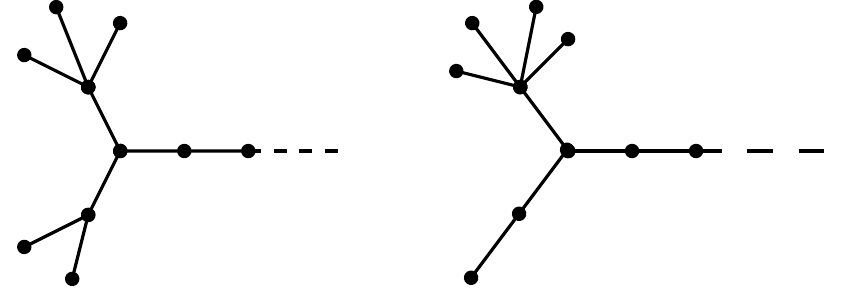
Figure 17: Two different cases with five peripheral vertices at one end of the skeleton.